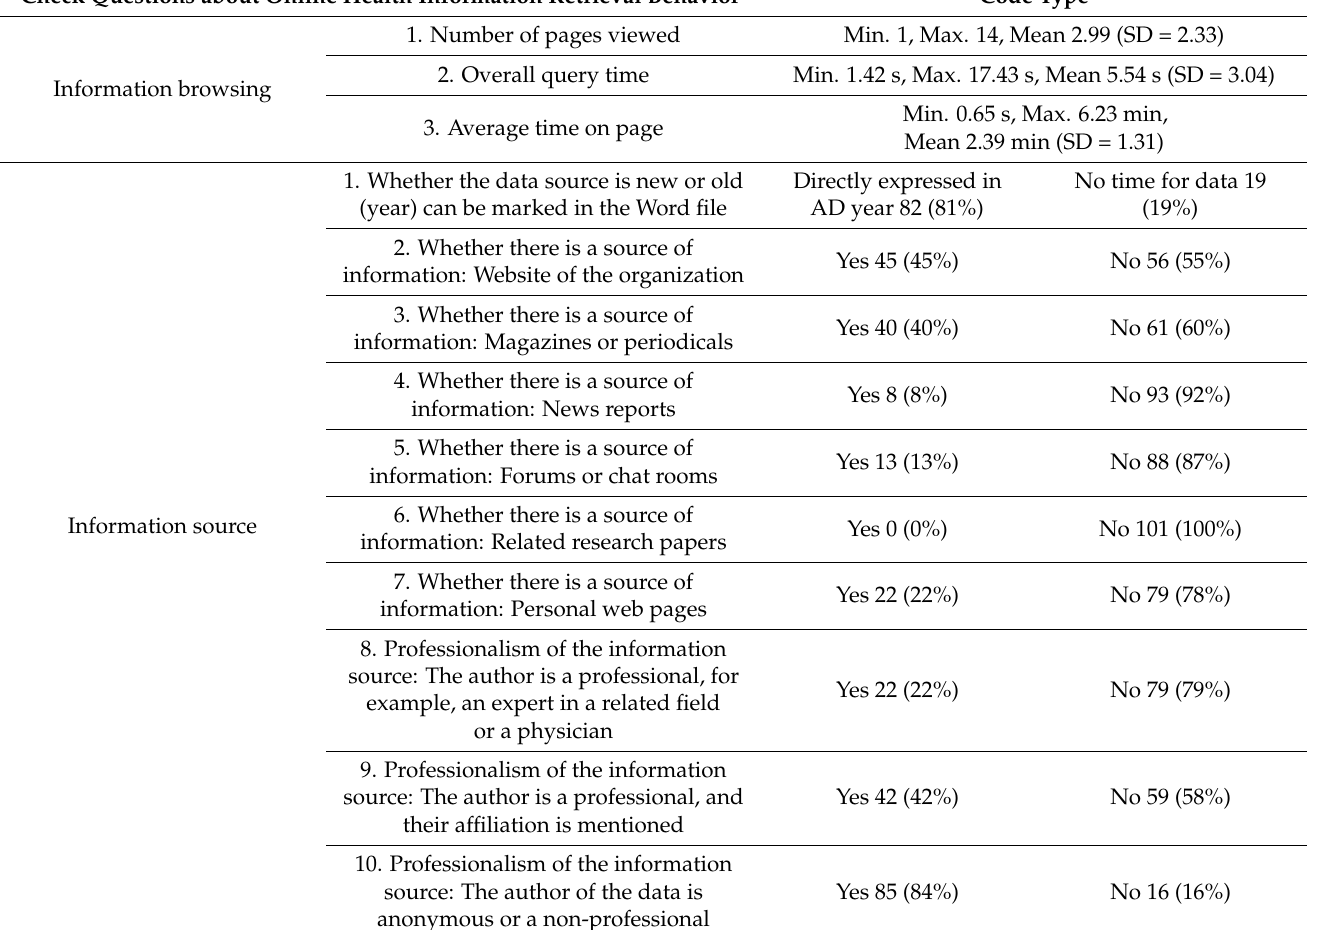
Table 3. Status of health information retrieval behavior among undergraduate students: Information browsing and information